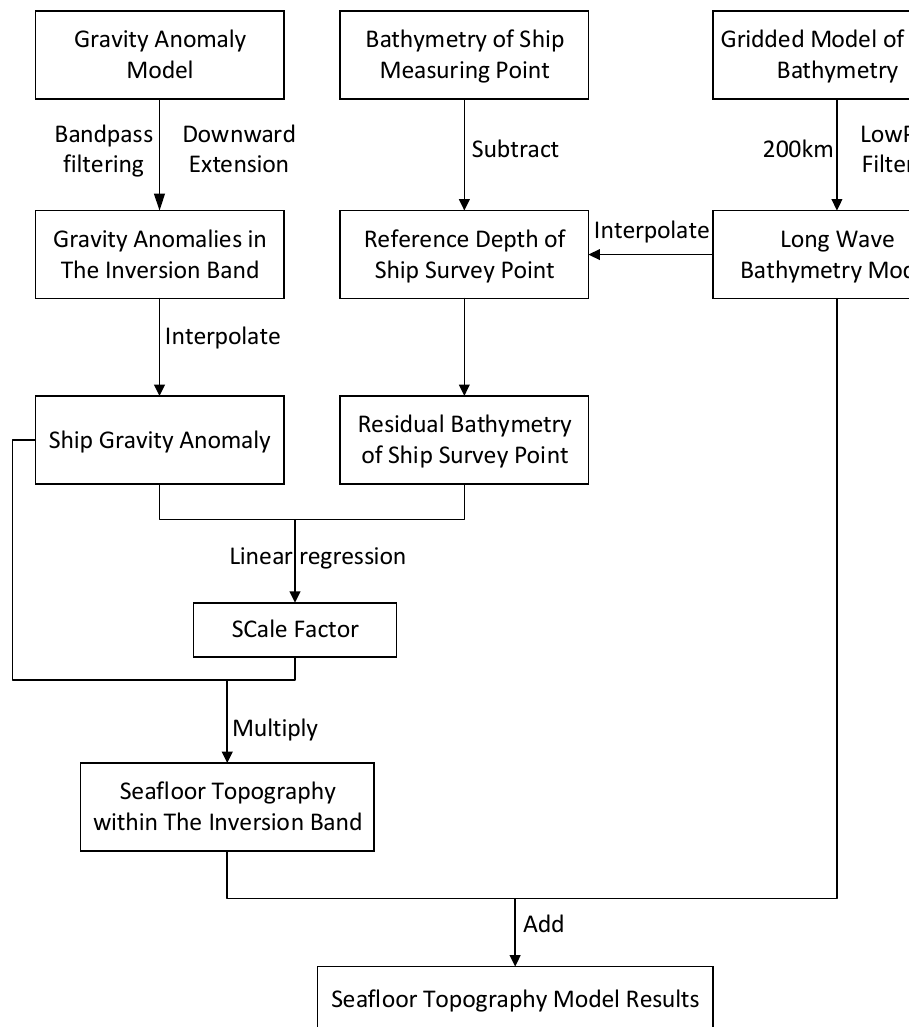
Figure 3. Inversion flow chart of seafloor topography processing.